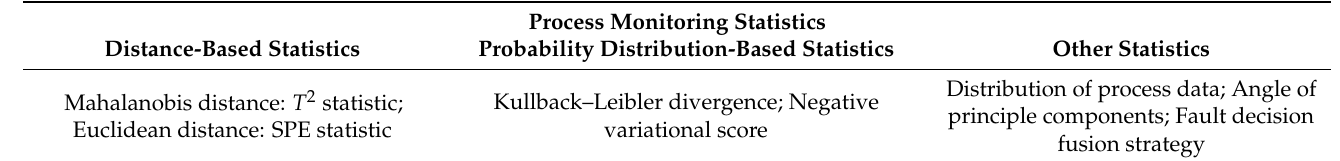
Table 3. A summary of different statistics for process